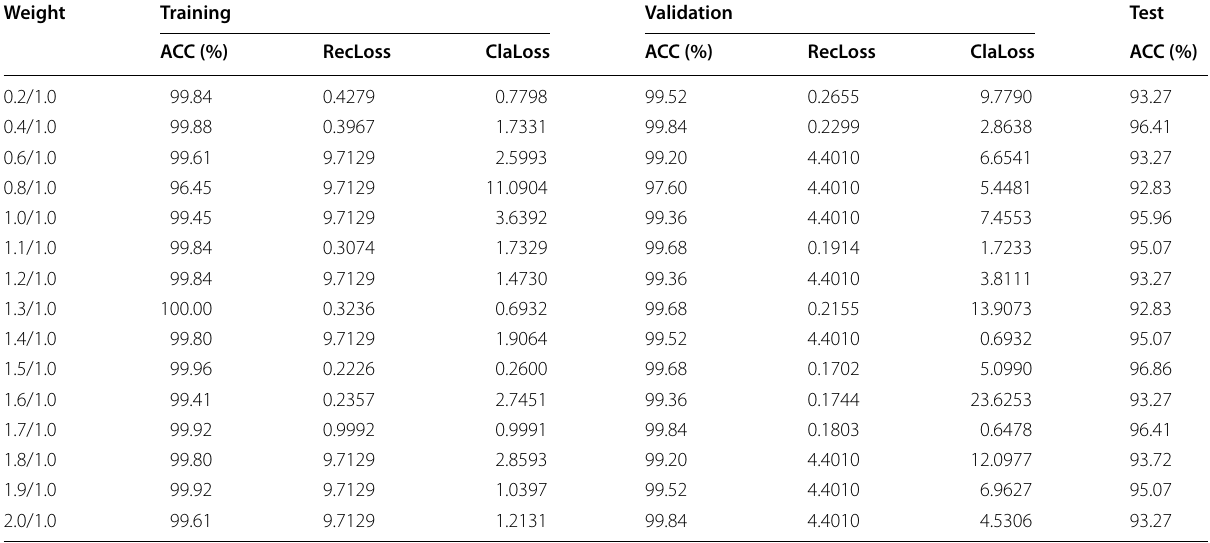
Table 1 Effects of weights on the performance of the DCNN